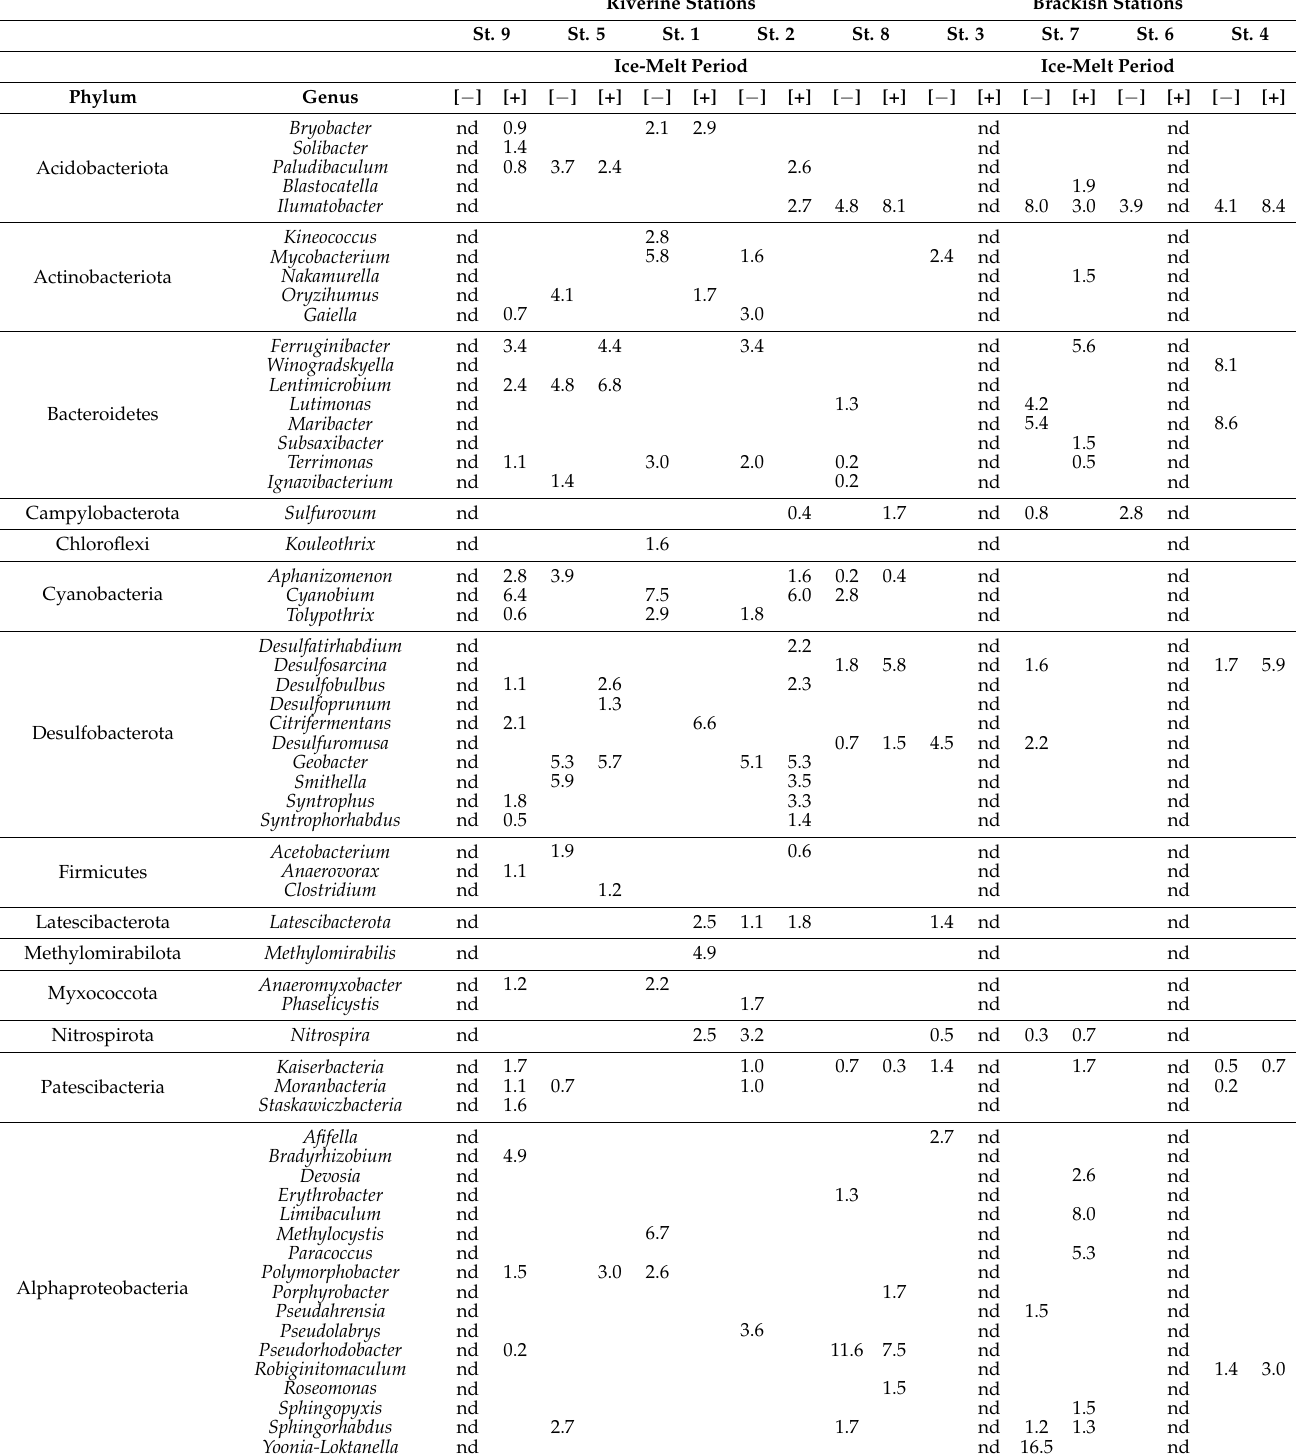
Table 4. Relative abundances of genera (>0.1%) occurring in the Pasvik